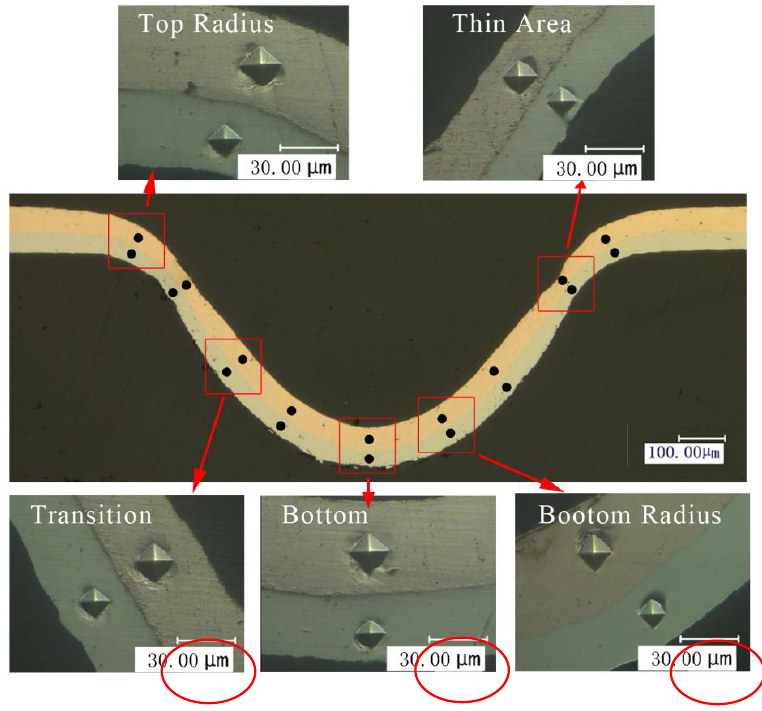
Figure 19. The distribution of micro-hardness test points.